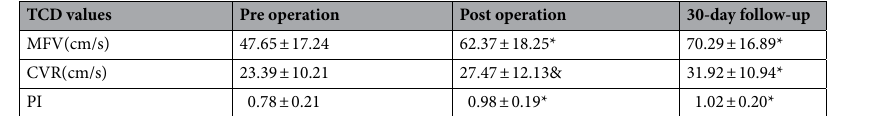
Table 2. Hemodynamic parameters in the operation patients in the operation group. With the released of carotid artery stenosis and the reconstruction of cerebral blood flow after CAS, the MFV and PI increased significantly in the ipsilateral MCA (*P < 0.05); the CVR improved significantly at the 30-day follow-up (*P < 0.05); CVR showed no statistical difference at 24 h after CAS ( & P > 0.05). TCD transcranial Doppler, MFV mean flow velocity, CVR cerebrovascular reserve, PI pulsatility